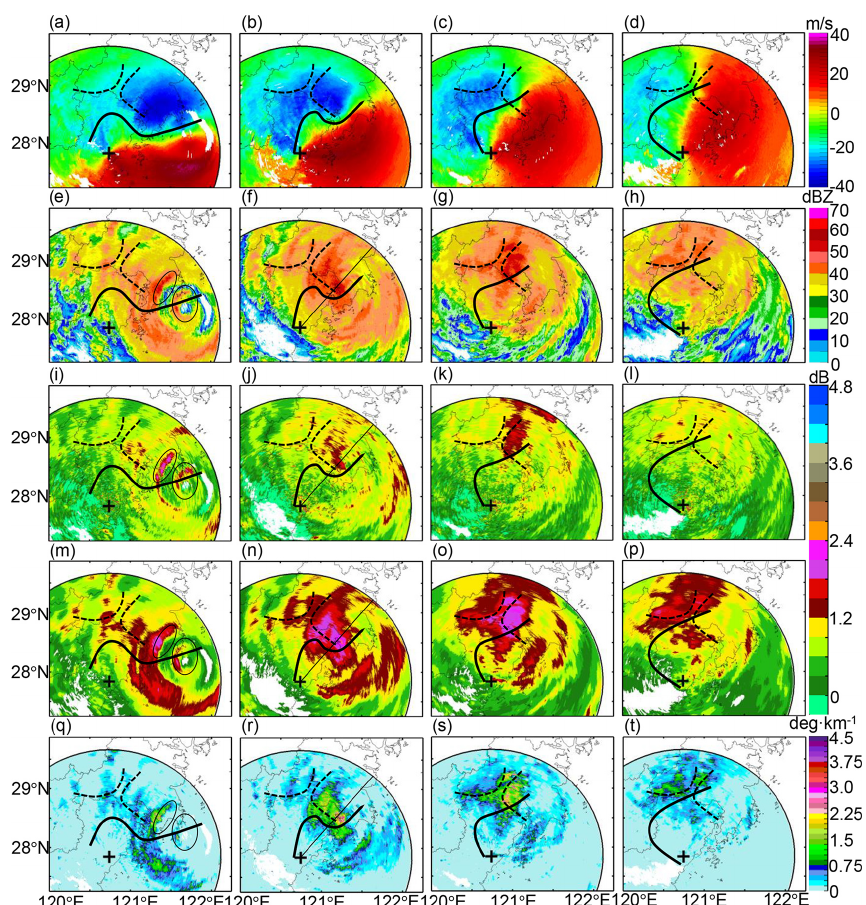
Figure 11. WZ-SPOL radar measurements during typhoon Lekima: (a) – (d) are Doppler velocity V R at 16:01, 17:59, 20:02, and 22:00UTC, 9 August 2019, respectively; (e) – (h) , (i) – (l) , (m) – (p) , (q) – (t) are, respectively, Z C black lines refer to wind shear deduced from V R . The dashed black lines refer to the GWS of KCM and YDM, and + indicates the location of the WZ-SPOL radar. The ellipses in (e) , (i) , (m) , and (q) indicate where hydrometeor size sorting occurred. The black lines along the radial profiles in (f) , (j) , (n) , and (r) indicate the azimuthal angle shown in Fig.